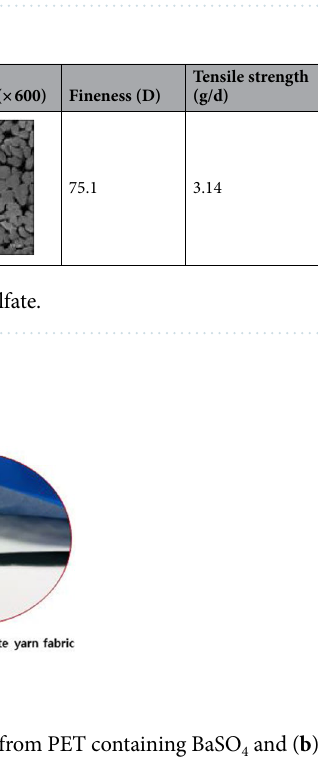
Figure 6. Low-dose radiation measuring equipment (Radcal 2186 [Accu-Dose], Radcal Co, 2017, Correction 2020).